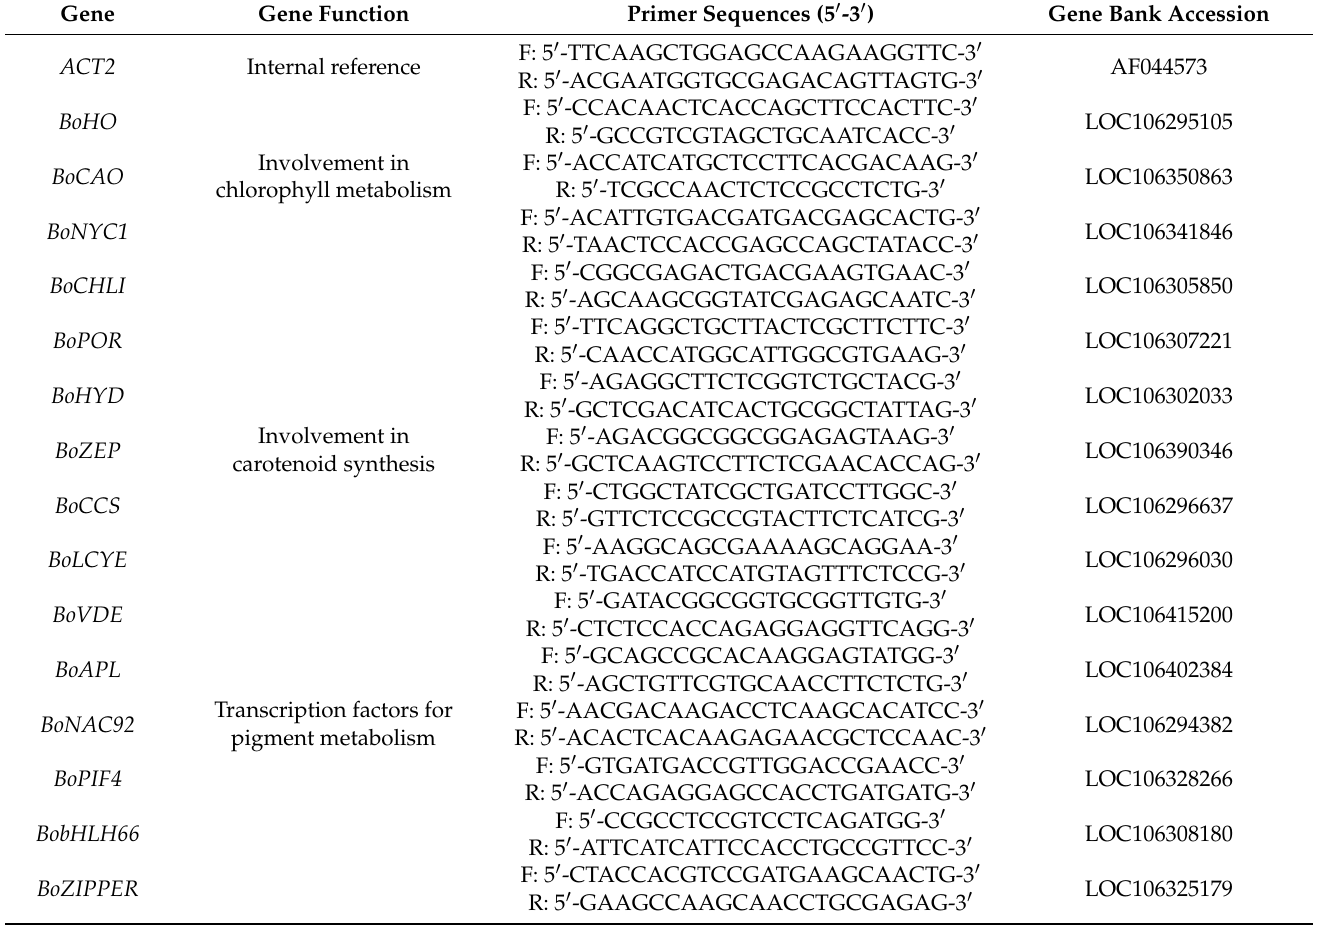
Table 1. Name and sequence of primers designed for genes related to broccoli